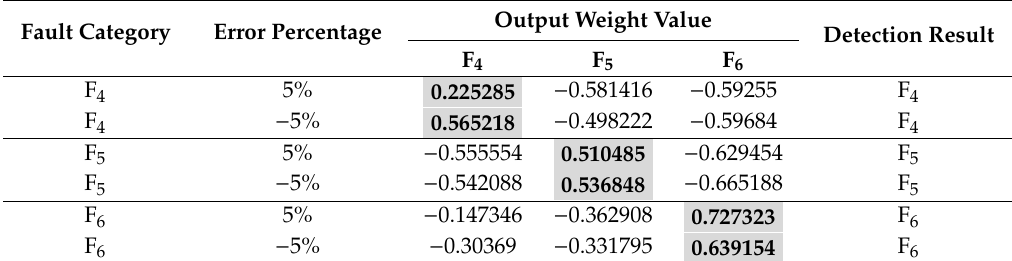
Table 7. Fault detection results under the failure of di ff erent switches fail in b -phase and addition of ± 5% erroneous data (inverter frequency = 60